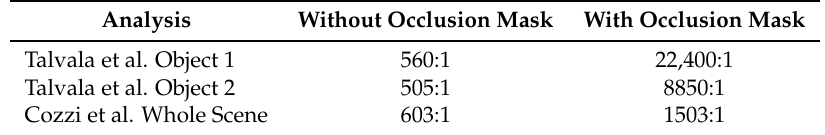
Table 2. Comparison of dynamic ranges measured on the HDRI with and without the occlusion